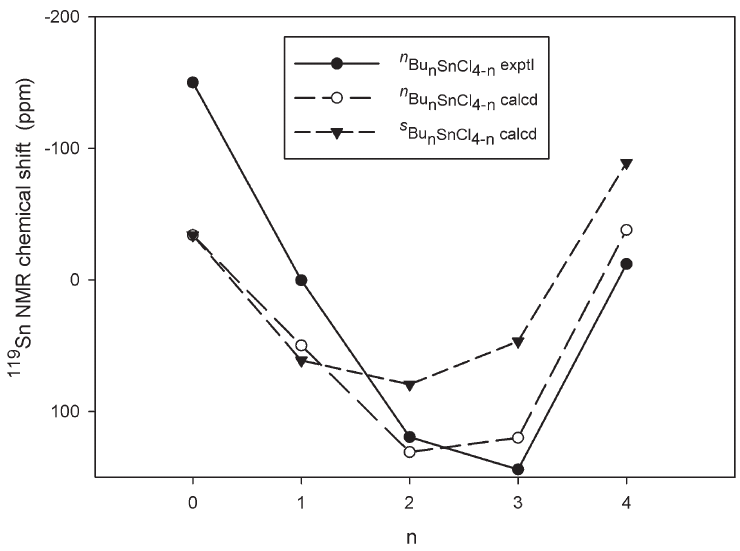
SnCl (X = n Bu, s Bu; n = 0 – 4) series of molecules. The n 4-n is taken from [19]. Other calculated 119 Sn 4